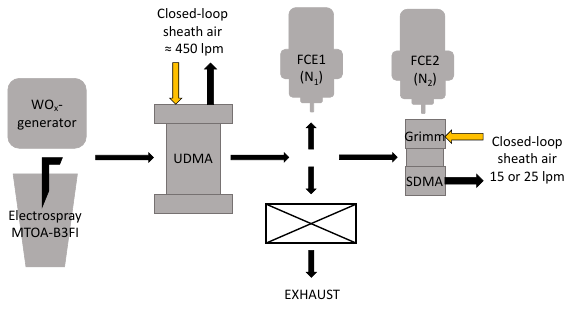
Figure 2. Calibration setup for the retrieval of the Grimm S-DMA transfer function and the gauging of the voltage–mobility relation. After aerosol generation particles are classified in a high-resolution DMA (UDMA) and then led into the Grimm S-DMA. Two Faraday cup electrometers (FCEs) are measuring the concentration upstream and downstream of the Grimm